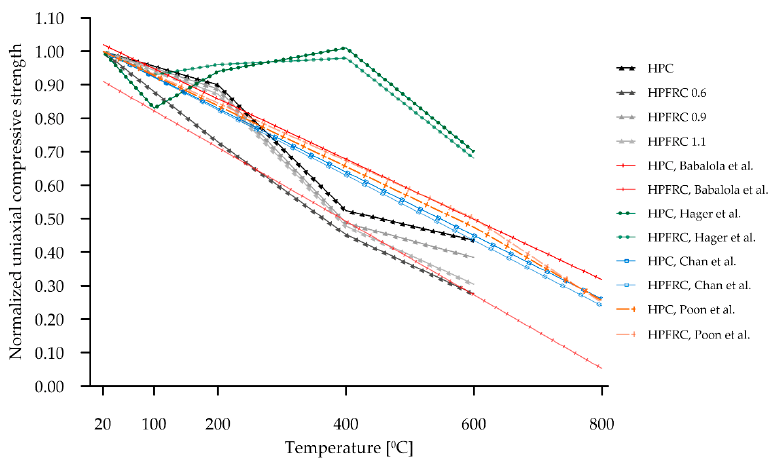
Figure 18. Comparison of residual compressive strength with literature data [35–38].